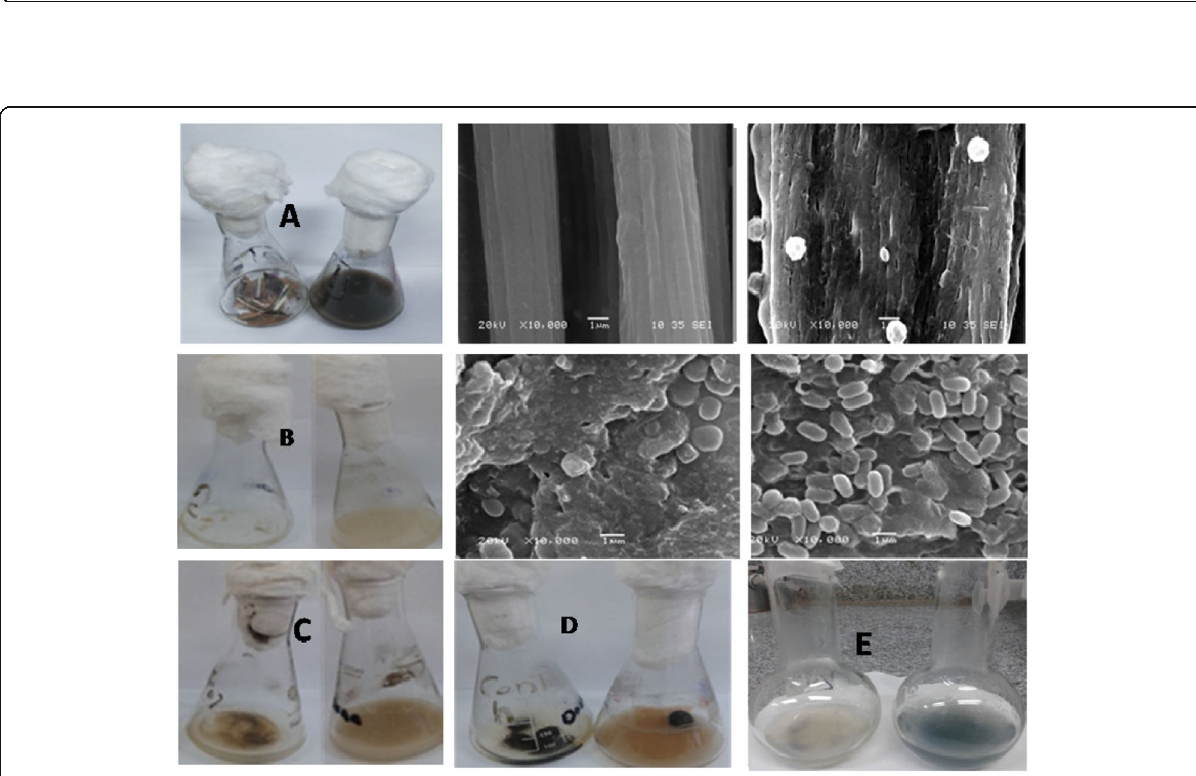
Fig. 3 Growth of Laceyella sacchari YNDH on feather ( a ), human nails ( b ), and relative SEM examination at × 10 magnification power for control (left) and sample (right). Growth of Laceyella sacchari YNDH on wool ( c ), human hair ( d ), and synthetic substrate keratin-azure ( e ), the control at left and the sample at